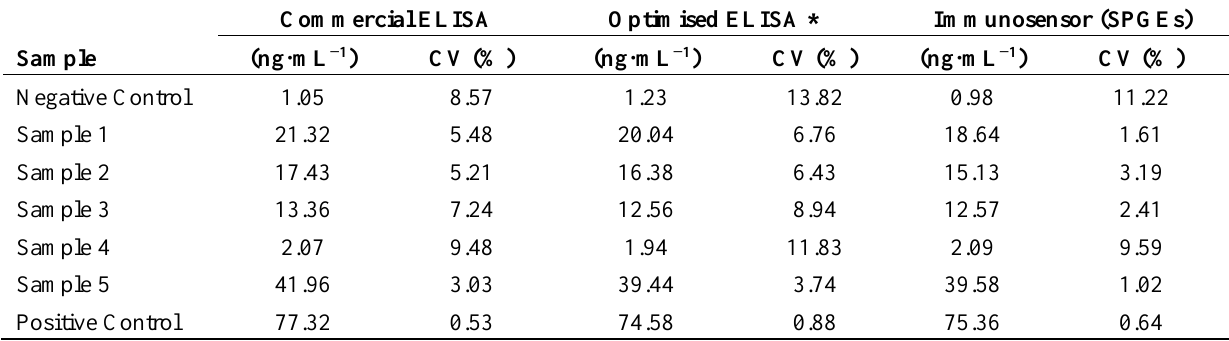
Table 2. Analysis of randomly spiked serum samples with different concentrations of CRP using both the commercial ELISA and the developed